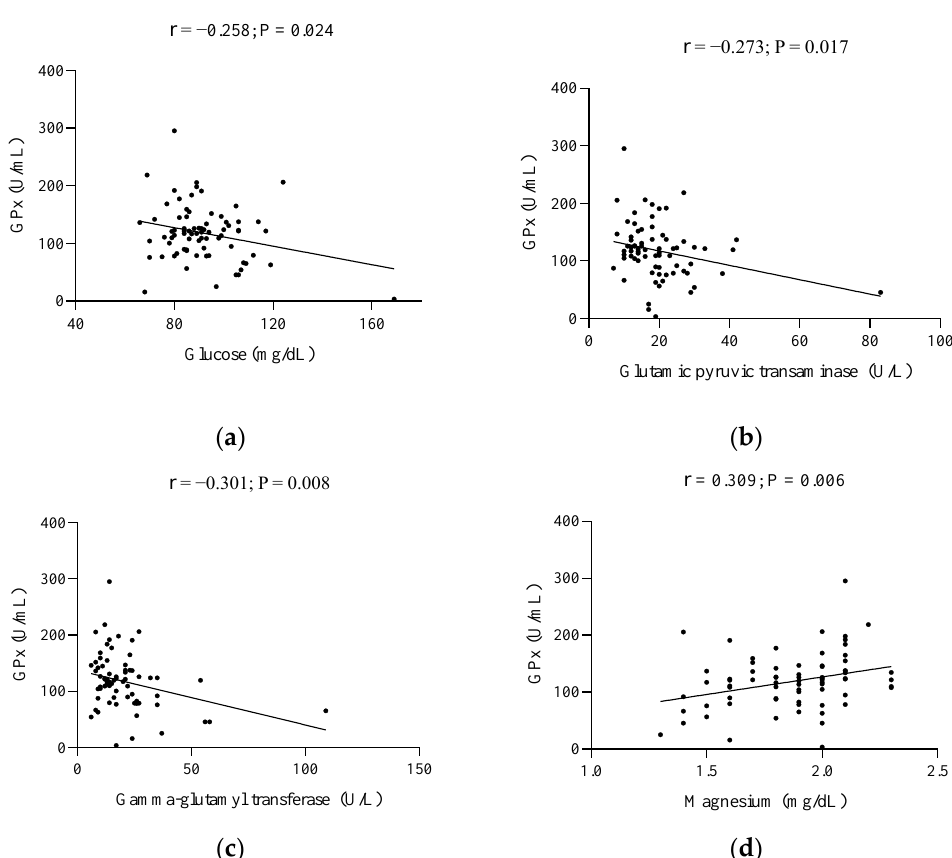
Figure 2. Significant associations of the body composition and biochemical parameters of the study with GPx. (a) glucose and GPx, (b) glutamic pyruvic transaminase and GPx, (c) gamma-glutamyl transferase and GPx, and (d) magnesium and GPx. r, Pearson’s correlation coefficient. A p -value less than 0.05 was considered significant. Abbreviations: GPx, glutathione peroxidase; GPT, glutamic pyruvic transaminase; GGT, gamma-glutamyl transferase; Mg, magnesium.